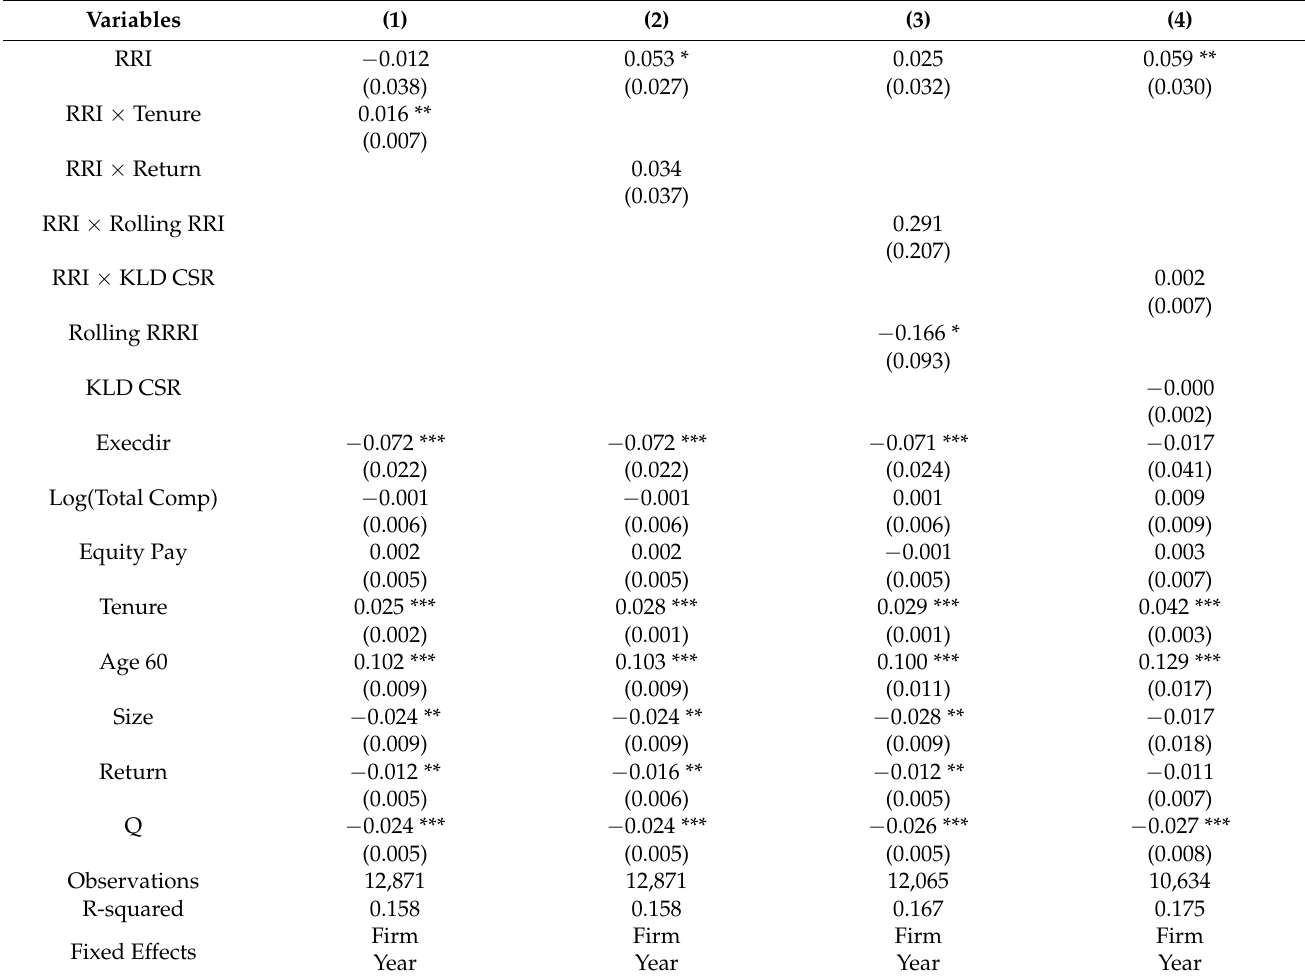
Table 6. Heterogenous effects. The dependent variable is CEO turnover. See the Appendix A for variable definitions. Standard errors are clustered by firm and reported in parentheses. *, ** and *** represent statistical significance at the 10%, 5% and 1% level,